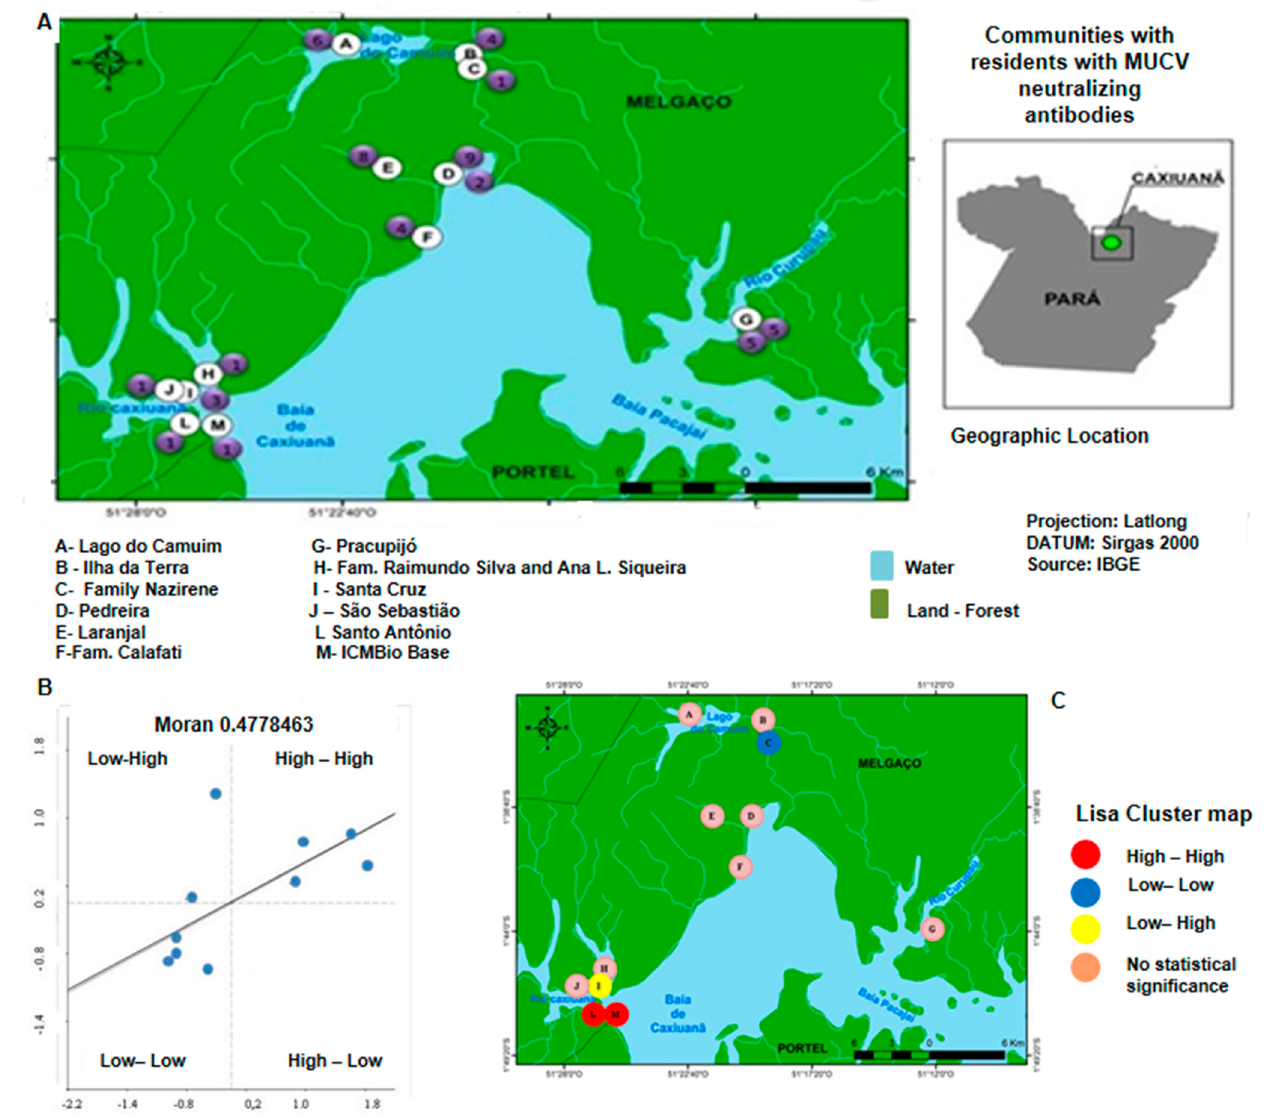
Figure 2. ( A ) Communities where residents presented neutralizing antibodies to MUCV. ( B ) The Moran scatter diagram. ( C ) Clusters. The number inside the purples spots (A) represents the number of inhabitants per community with neutralizing MUCV antibodies. The Moran scatter diagram (B) indicates a strong spatial autocorrelation. The analysis of clusters (C) revealed the presence of four types of clusters: High-High; Low-Low; Low-High; High-Low. The value presented by the Moran scatter plot (v = 0.4778463) indicated a strong positive spatial autocorrelation, demonstrating a spatial association between the localities.